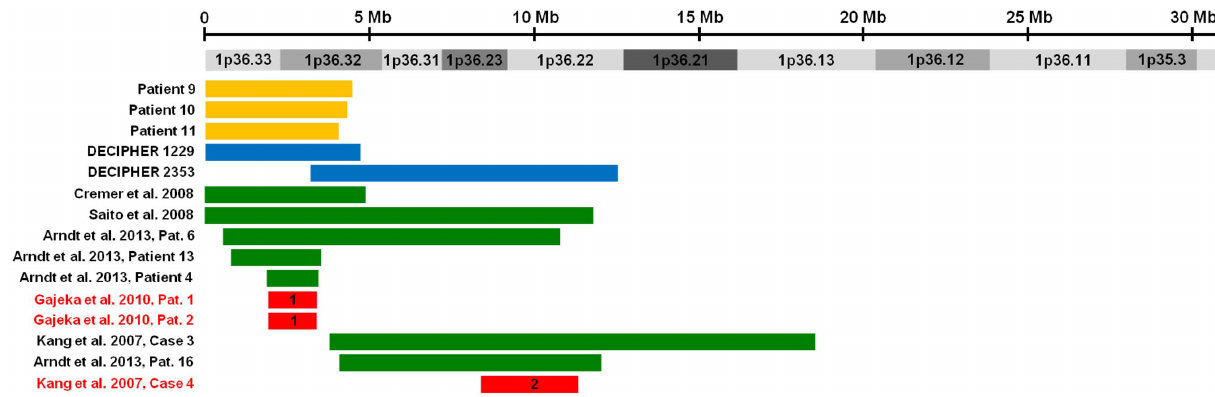
Figure 2. Delineation of two critical regions for cardiomyopathy on 1p36. Solid bars represent isolated 1p36 deletions identified in individuals with cardiomyopathy. These deletions are grouped based on the source from which data was obtained: 1) patients referred to the Medical Genetics Laboratories at Baylor College of Medicine for copy number analysis and 2) patients recruited into a research study on 1p36 deletions at Baylor College of Medicine [orange], 3) the DECIPHER database [blue], and 4) a review of the literature [green]. Deletions that define non-overlapping critical region for cardiomyopathy are shown in red and are numbered sequentially from the telomere.